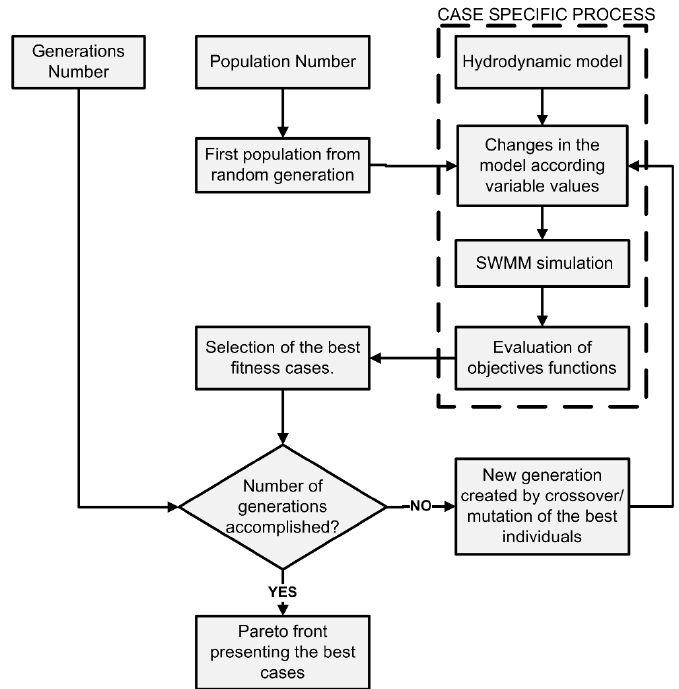
Figure 3. Optimization framework.